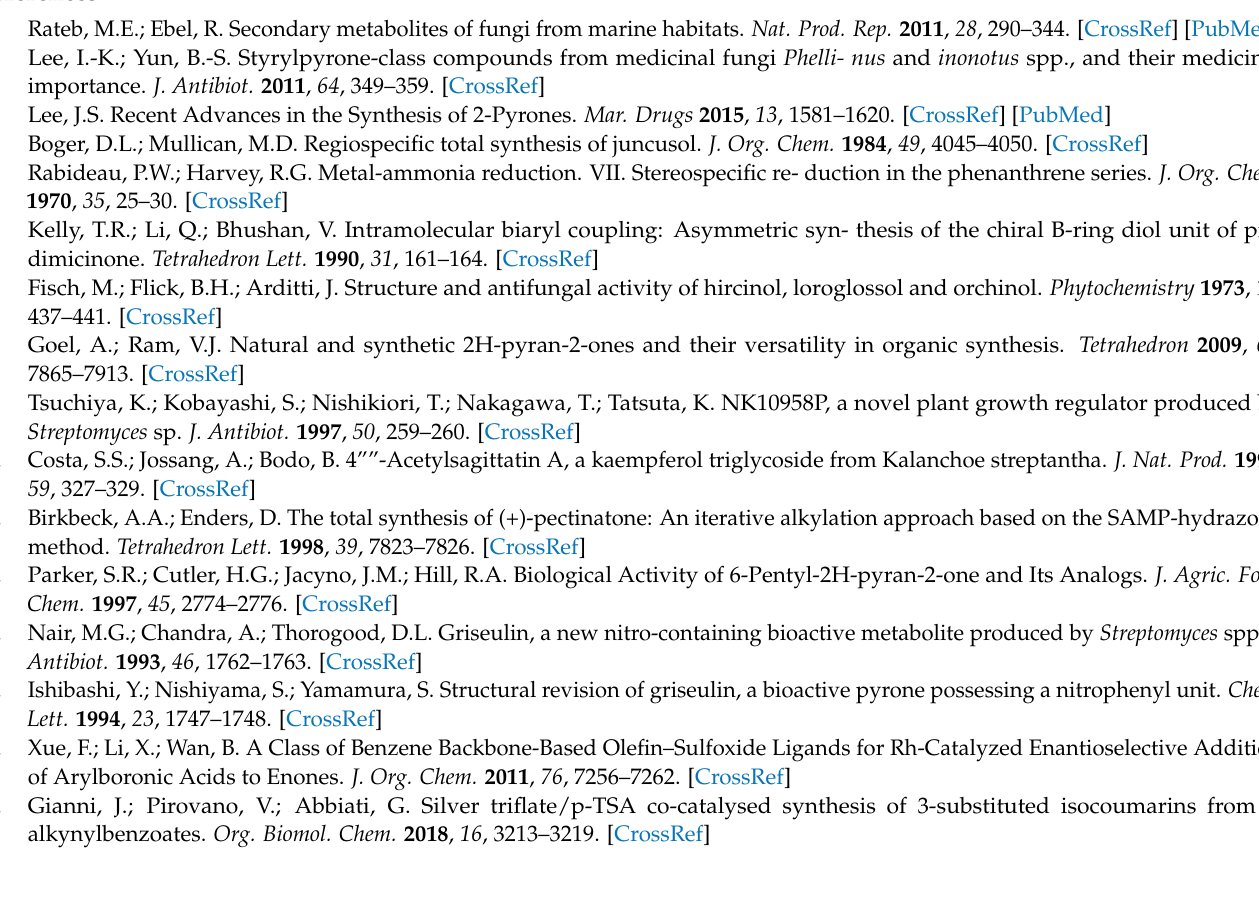
of 4 ; Figure S5 Hirshfeld surfaces of 5 ; Figure S6 Hirshfeld surfaces for one molecular unit of 6 ; Table S1 Crystal data and structure refinement for 1 ; Table S2 Bond lengths (Å) and angles ( ◦ ) for 1 ; Table S3 The calculated geometric parameters of 1 ;Table S4 The calculated geometric parameters of 2 ; Table S5 The calculated geometric parameters of 3 ; Table S6 The calculated geometric parameters of 4 ; Table S7 The calculated geometric parameters of 5 ; Table S8 The calculated geometric parameters of 6 ; Table S9 Natural charges (NC) at the different atomic sites in the studied molecules; Table S10 The calculated and experimental NMR chemical shifts of 1 ; Table S11 The calculated and experimental NMR chemical shifts of 2 ; Table S12 The calculated and experimental NMR chemical shifts of 3 ; Table S13 The calculated and experimental NMR chemical shifts of 4 ; Table S14 The calculated and experimental NMR chemical shifts of 5 ; Table S15 The calculated and experimental NMR chemical shifts of 6 ; Table S16 Calculated energies and thermodynamic parameters for the suggested isomers of the studied pyran-2,4-dione a